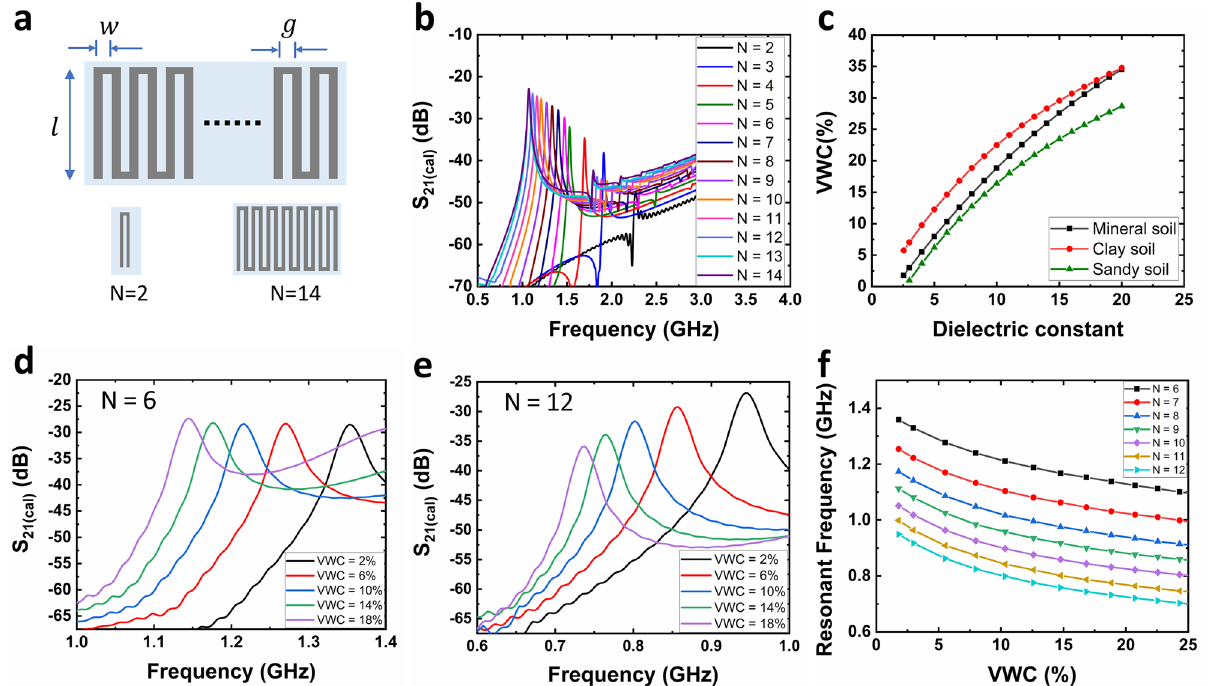
Figure 2. Schematic illustration of meander line structure and simulation-based optimization. ( a ) Meander line structure formation starting from N = 2 to N = 14 with optimization variables indicating various dimensions. ( b ) Simulation results showing S 21 ( cal ) vs. frequency plots for N ranging from 2 to 14. ( c ) Demonstration of empirical equations demonstrating ε eff as a function of VWC for mineral soil, clay soil, and sandy soil. ( d ) Simulation results for N = 6 showing S 21 vs. frequency plots for various VWC values. ( e ) Simulation results for N = 12 showing S 21 vs. frequency plots for various VWC values. ( f ) Extracted values of f r obtained from simulations plotted as a function of VWC for N in the range 6 to 12.